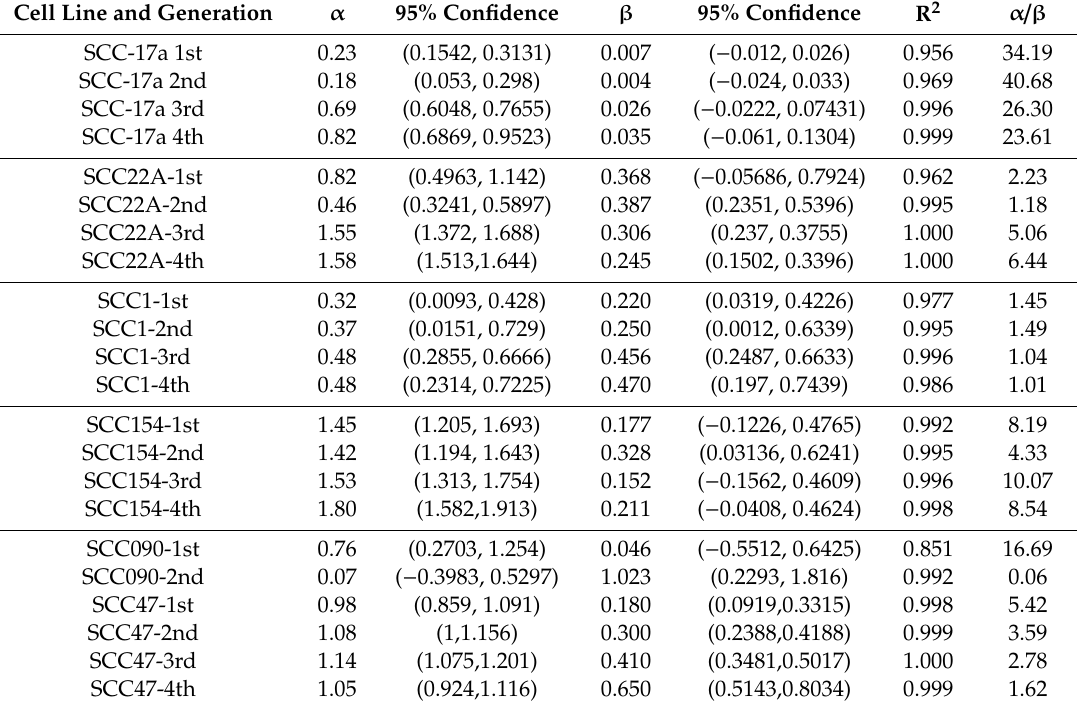
Table A2. Modelling parameters and α / β by R 2